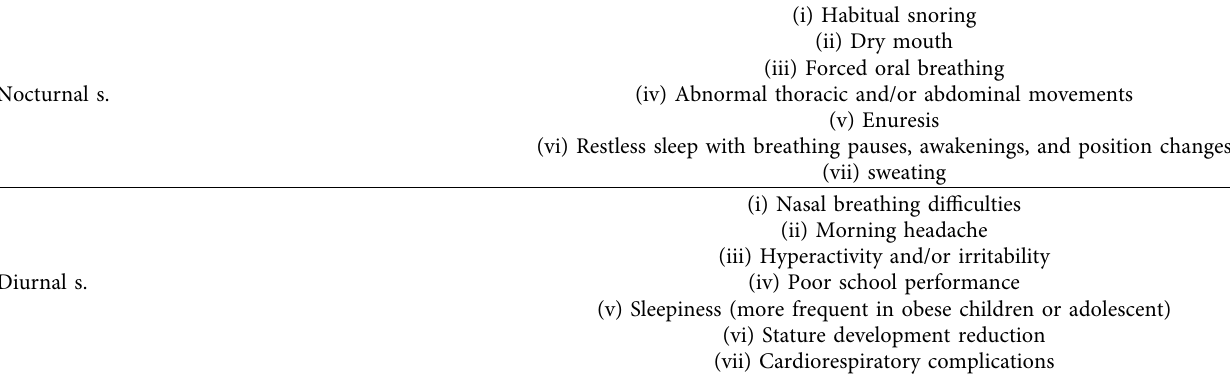
Table 1: Clinical manifestation of OSAS in the pediatric age: diurnal and nocturnal symptoms.